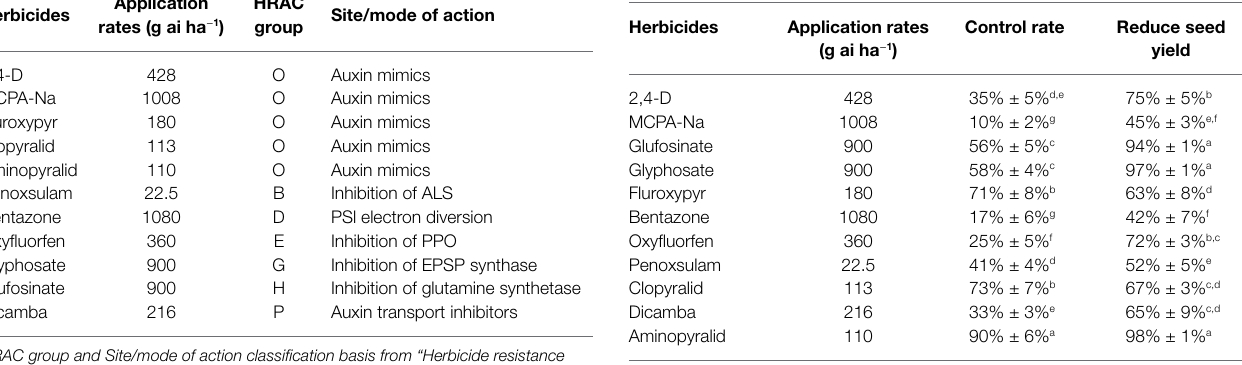
TABLE 3 | Effects of different herbicides on control rate and seed yield of Ambrosia artemisiifolia .